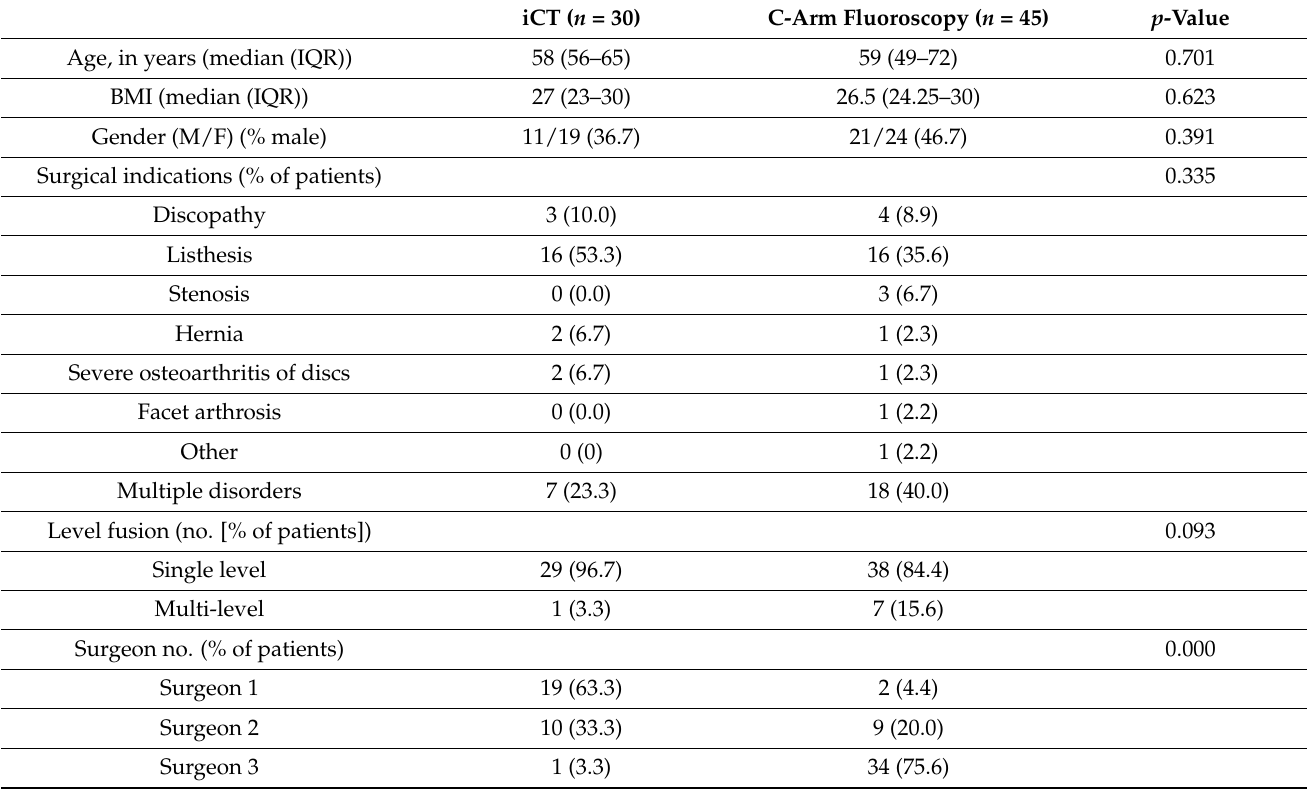
Table 1. Basic characteristics of the study population per group.